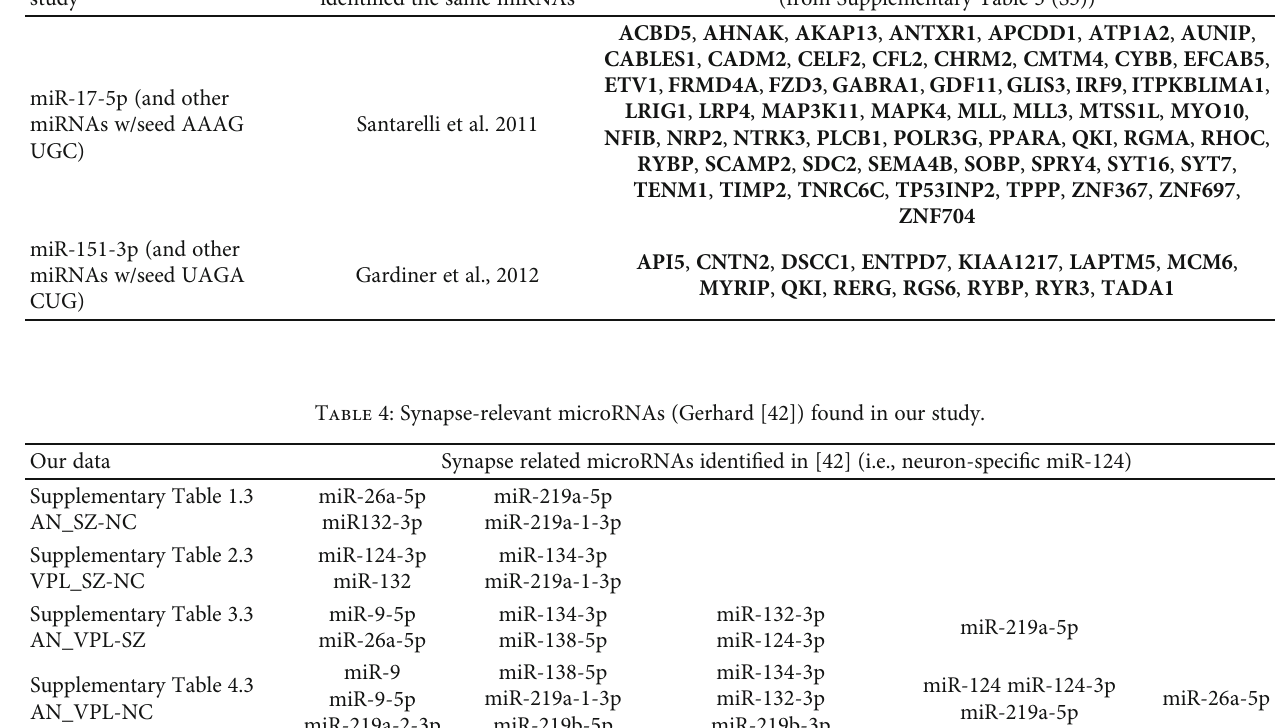
Table 3: Schizophrenia-associated microRNAs found across independent studies (reviewed in [55]) identi fi ed in our SZ_VPL vs. AN comparison (Supplementary Table 3.3). Their targets, found in our SZ cohort, are bolded. Upstream regulator in our